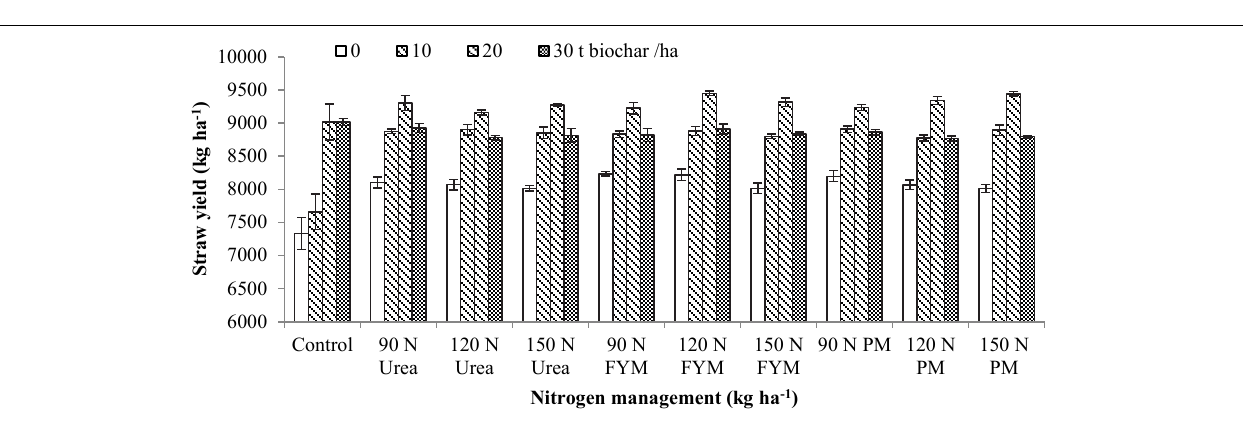
FIGURE 2 | Interactive effect of biochar and N levels applied from different sources on straw yield of wheat. Bars on the graph denote the SE of mean ( n = 3). FYM, farmyard manure; PM, poultry manure.